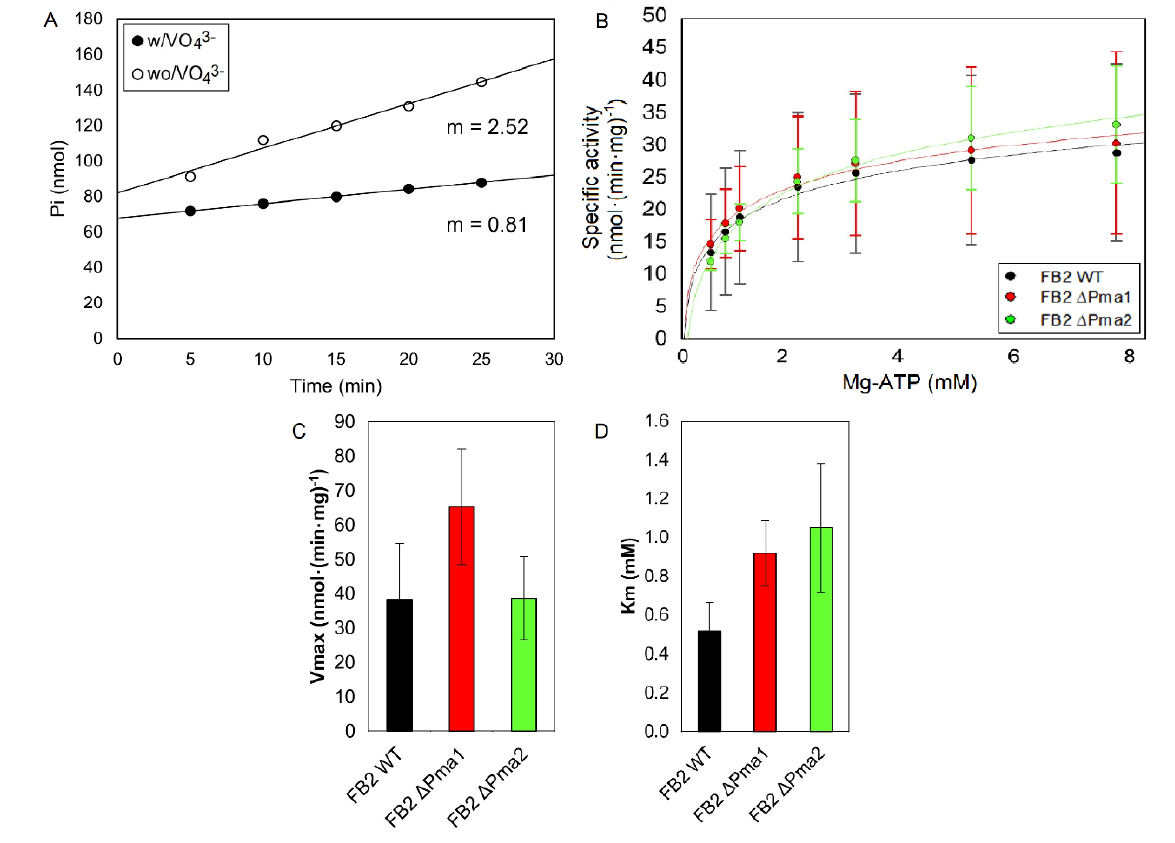
Figure 2. Ustilago maydis plasma membrane ATPase activity. U. maydis wild-type and mutant strains were grown for 24 h in YPD media. Cells were harvested and the plasma membrane was isolated as described in Materials and Methods. ATPase activity was measured in the presence or absence of orthovanadate, and the vanadate-sensitive ATPase activity was measured at different concentrations of the substrate Mg-ATP. Vmax and Km values were obtained by fitting the data to the Michaelis–Menten equation. Inorganic phosphate released from ATP by the plasma membrane H + -ATPase was measured, in accordance with Fiske and Subbarrow [27]. The specific activity is reported as nmol Pi · (min · mg protein) − 1 . ( A ). Time course of phosphate production by the plasma membrane H + -ATPase in the presence or absence of 100 µ M orthovanadate and 0.5 mM Mg-ATP. ( B ). Variation of ATPase activity with Mg-ATP concentration. ( C ). Maximum velocity values. ( D ). Michaelis–Menten constant values. One-way ANOVA analysis was performed and no statistically significant difference was found between strains using p < 0.05 (n ≥ 3). Bars represent the standard error of the mean; m: